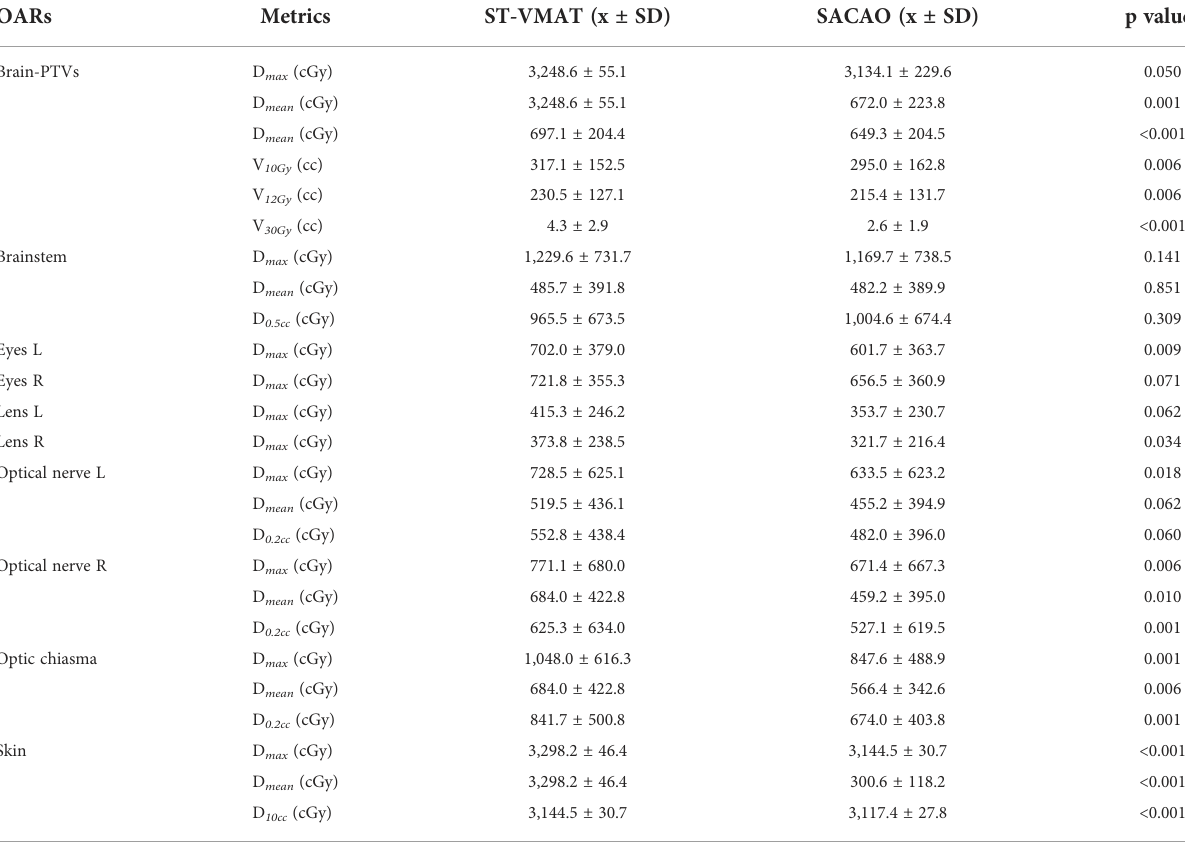
TABLE 4 Dosimetric statistics of OARs for 20 patients in terms of mean, standard deviation (SD), and related p